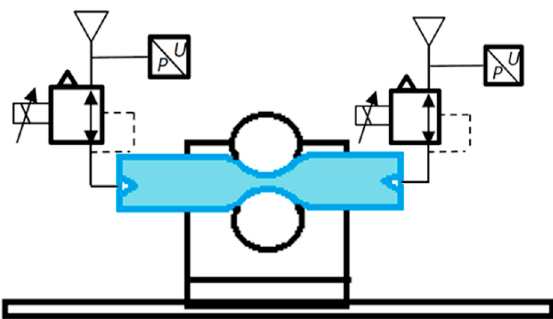
Figure 11. Experimental setup for the static friction force assessment of the PLPA. Information 2020 , 11 , 76